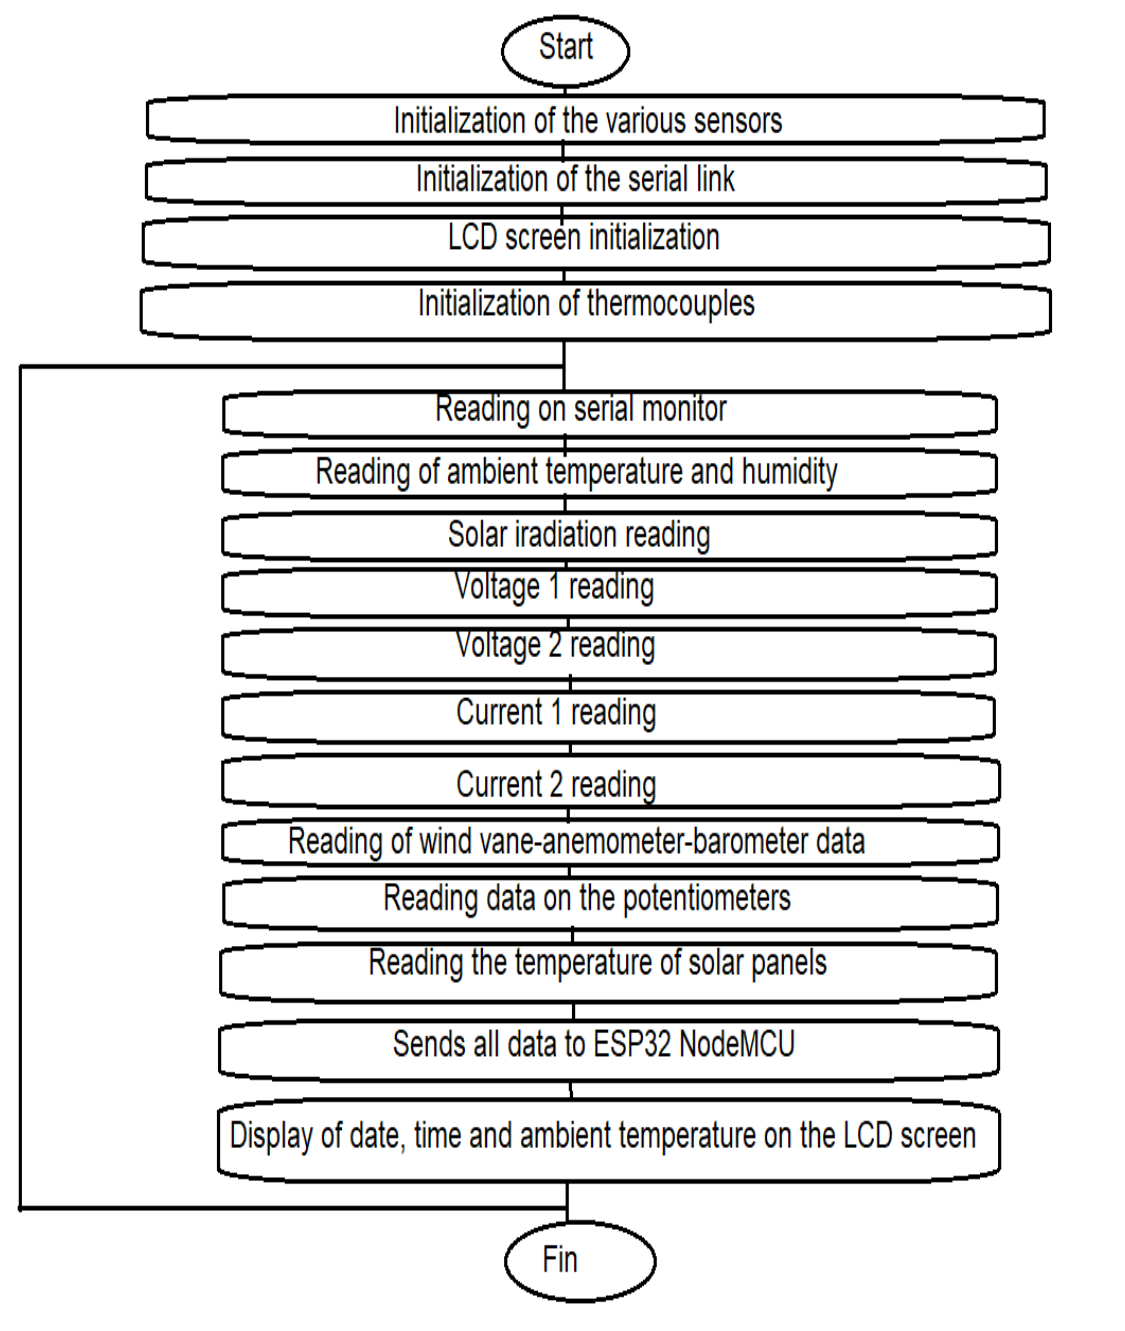
Figure 5a: Flowchart of the program driving the Arduino